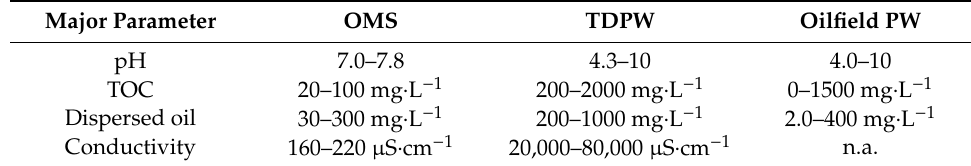
Table 3. Characteristics of oily model solutions (OMSs) and tank-dewatering produced water (TDPW) compared to oilfield produced water (PW). Conductivity data for the oilfield PW were not available (n.a.).